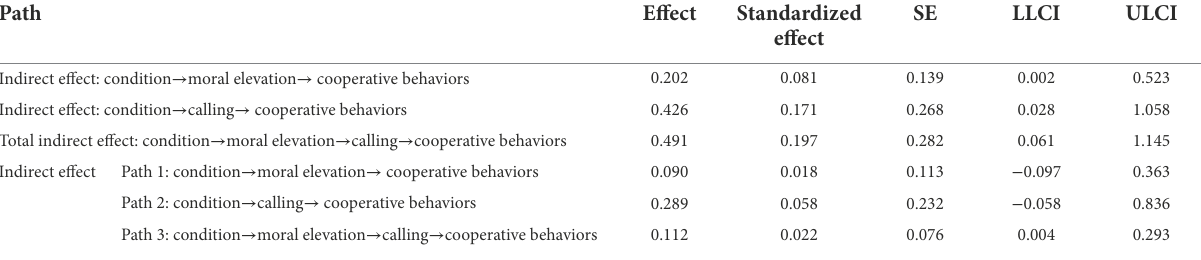
TABLE 3 The chain-mediation effect and 95% confidence interval estimated by the bootstrap method. Path